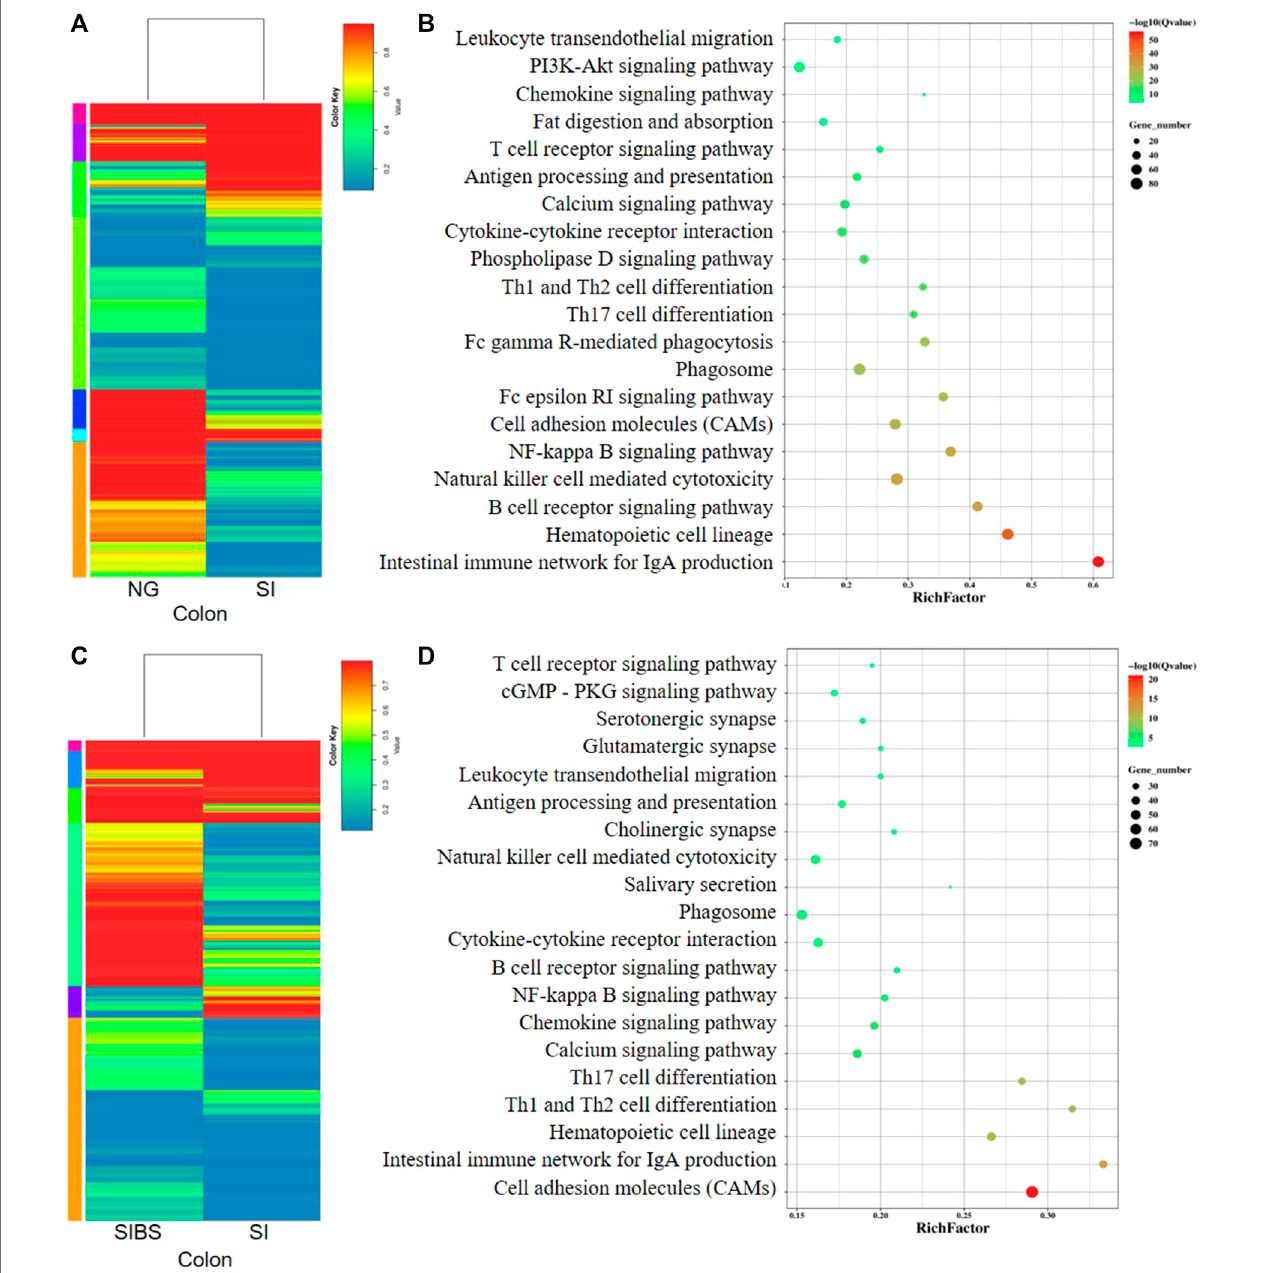
FIGURE 6 | Comparison of DEGs in the colonal tissues were analyzed by KEGG enrichment analysis. (A,B) Comparison of DGEs between the NG and SI groups. (C,D) Comparison of DGEs between the SIBS and SI groups. NG: normal mice with PBS group. SI: S. japonicum – infected mice group. SIBS: S. japonicum – infected mice with OA B. subtilis group. The size of each circle represents the number of genes.